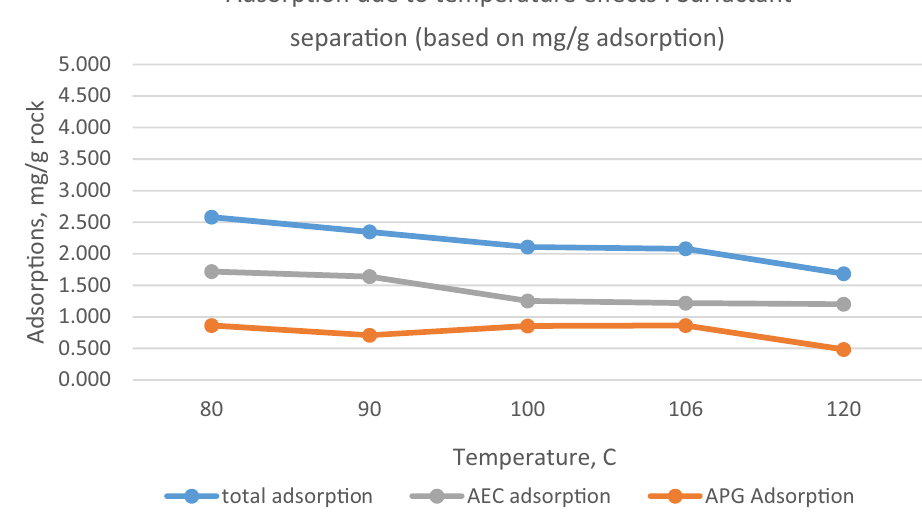
Fig. 16 Surfactant separation for adsorption due to tempera- ture effects